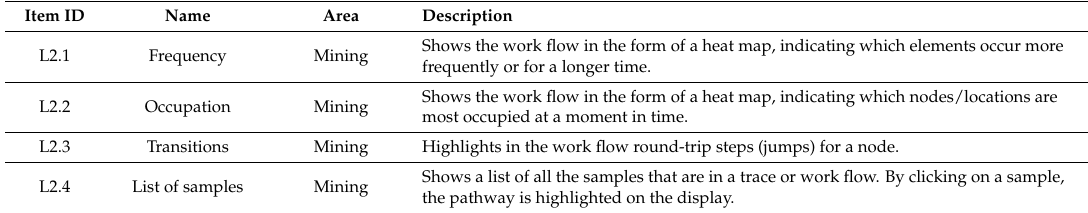
Table 2. Structure and items of the mining area in the process mining dashboard under evaluation.